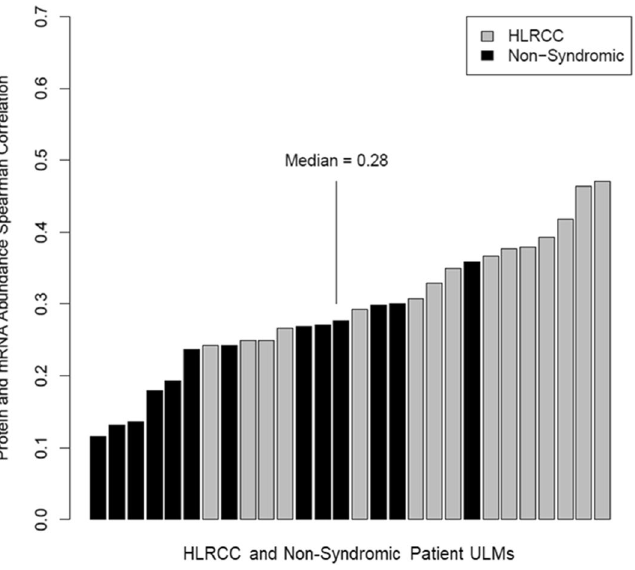
Figure 3. Correlation of protein and transcript abundance in ULMs from Hereditary Leiomyomatosis and Renal Cell Cancer (HLRCC) and non-syndromic (NS) patients. Bar plot details Spearman Rho correlations calculated for each ULM analyses based on 3411 co-quantified proteins and transcripts. Median Spearman Rho for HLRCC, R = 0.35 was significantly higher than for non-syndromic ULMs, R = 0.242, Mann Whitney U p = 0.0015.